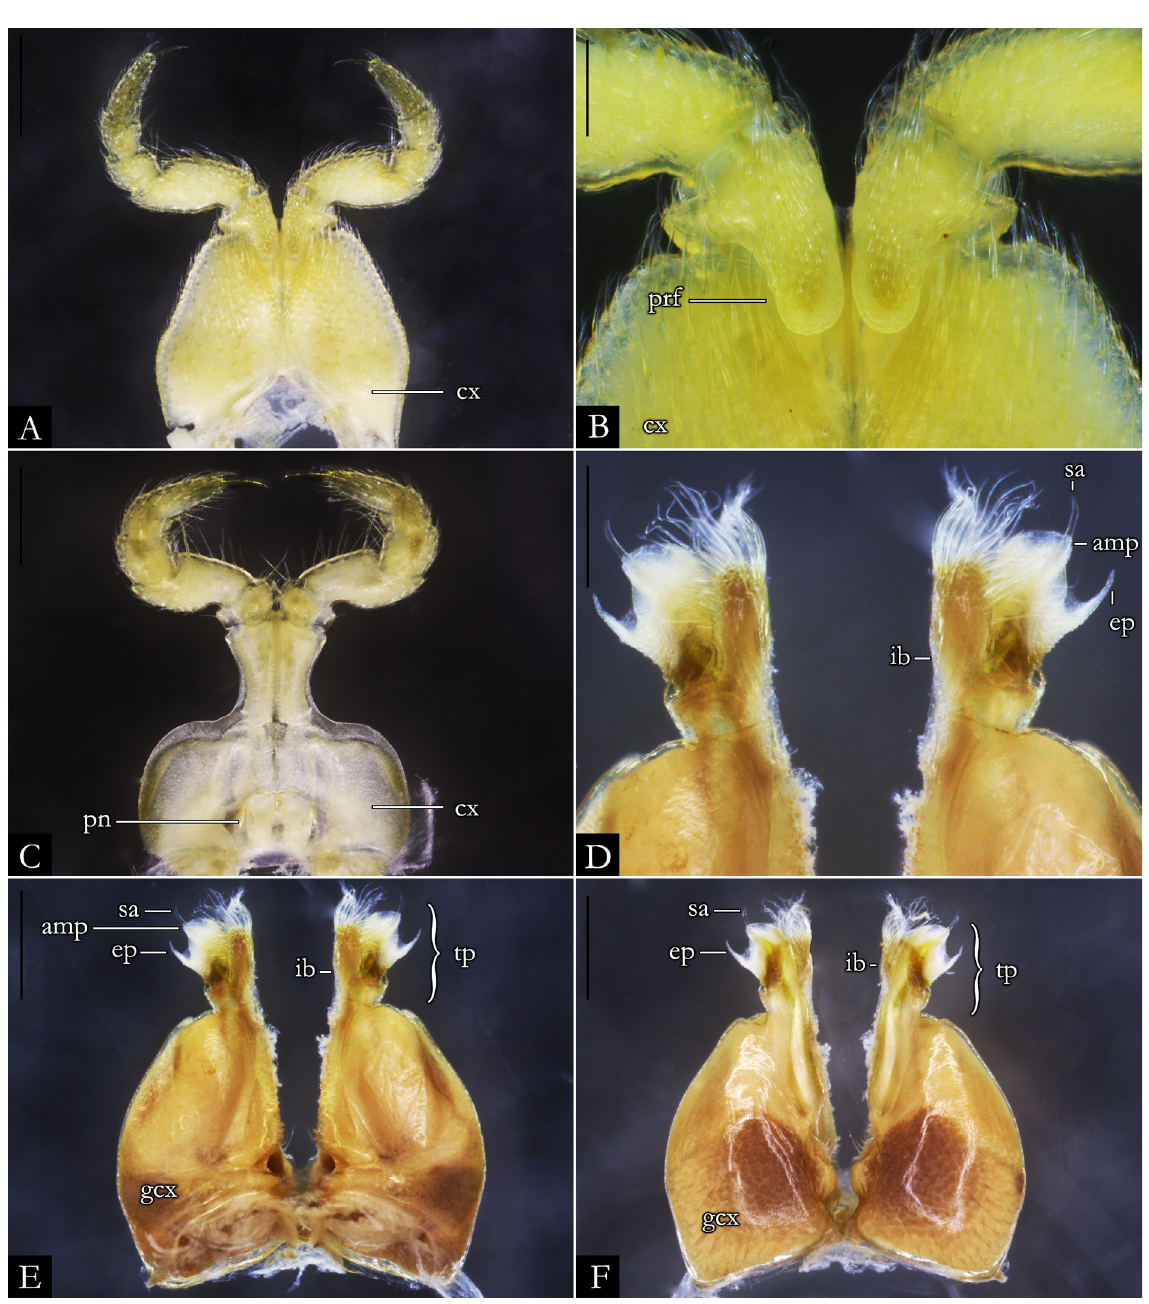
Fig. 110. Pseudonannolene paulista Brölemann, 1902, ♂ (IBSP 1908). A . First leg-pair. B . Detail of prefemur. C . Second leg-pair. D . Detail of telopodites, in anal view. E . Gonopods, in anal view. F . Gonopods, in oral view. Abbreviations: see Material and methods. Scale bars: A, C, E–F = 0.5 mm; B, D = 0.2